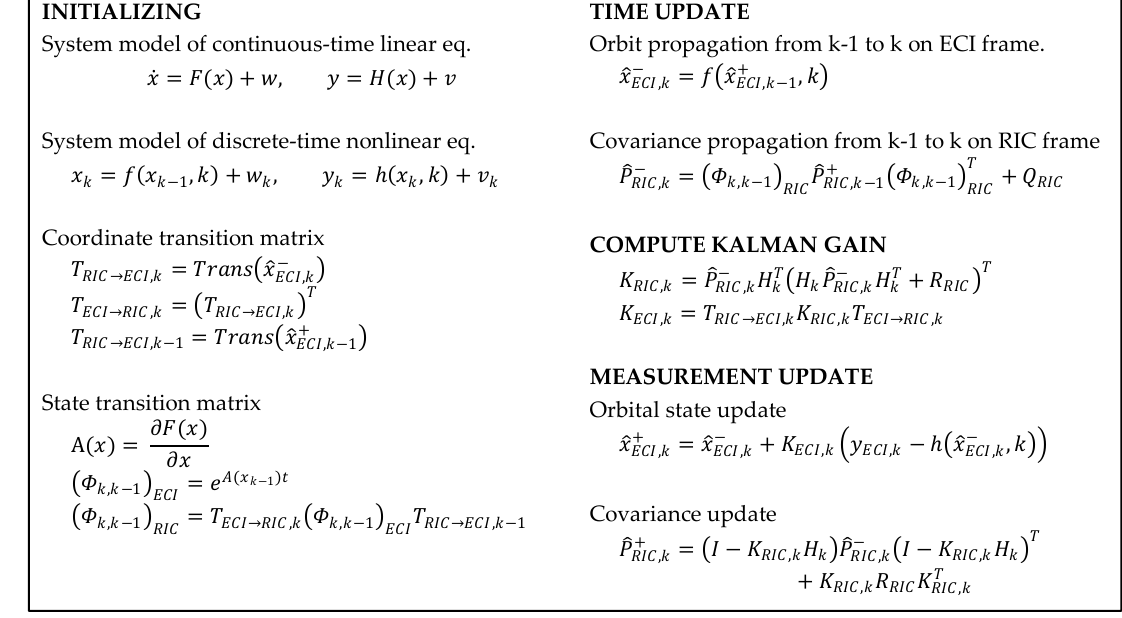
Figure 6. Orbit determination logic using extended Kalman filter on the RIC orbital frame.